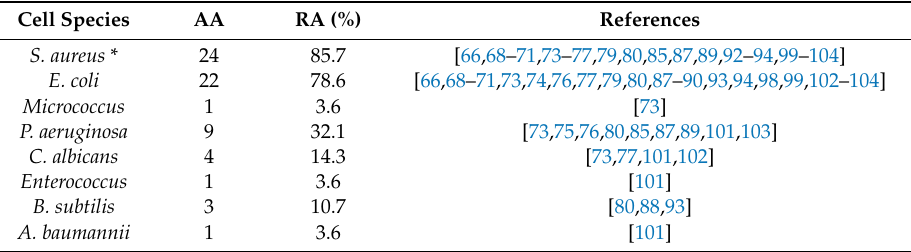
Table 5. Frequency of tested bacteria and fungi for wound